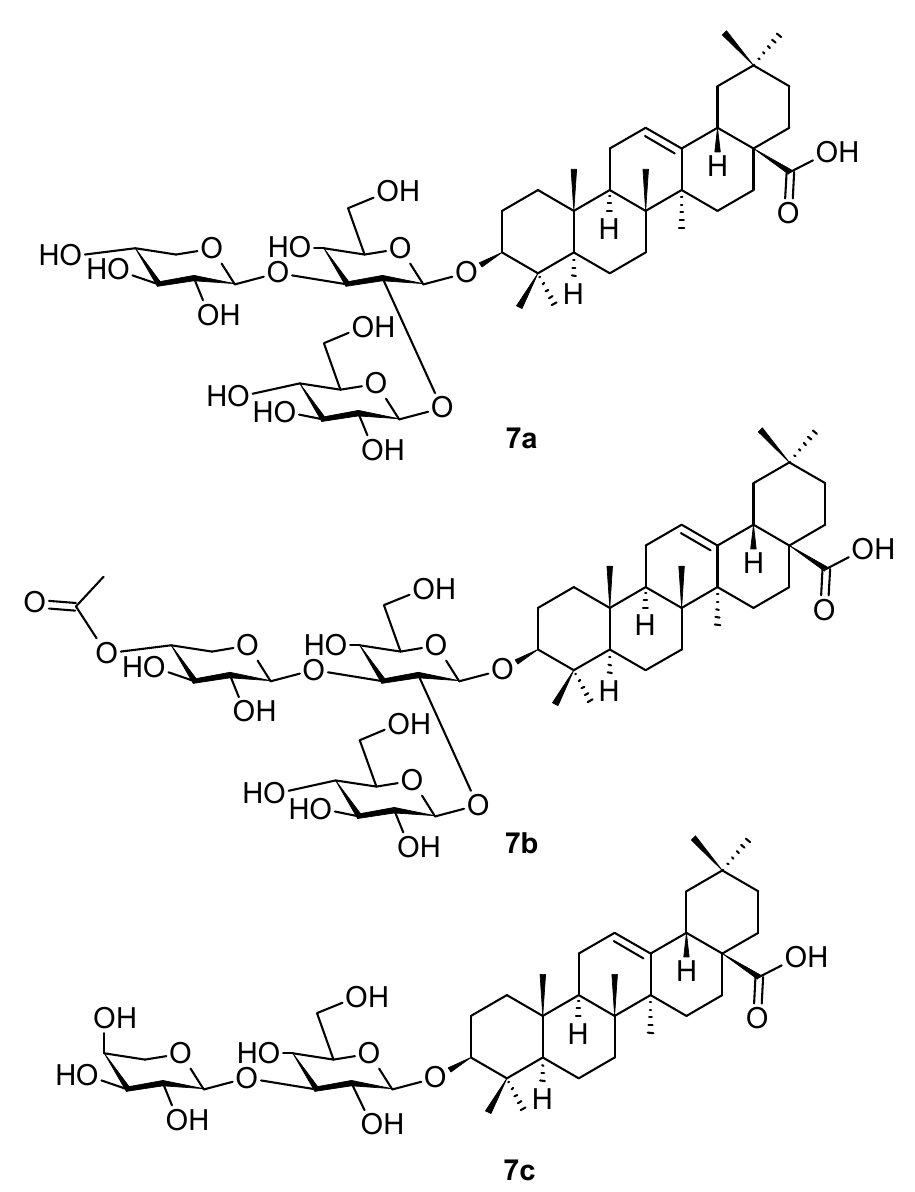
Figure 7. Oleanane-type lepiginosides 7a – 7c from the stem bark of Lepisanthes rubiginosa . Xanthoceraside ( 8 ; Figure 8), another oleanane-type saponin, was isolated from Xan- of the saponins of the oleanane-type of triterpenoids, have been isolated and identified from Platycodon grandiflorus Jacq. (Campanulaceae; Chinese bellflower), a well-known edible and medicinal plant [52]. The general formula 9a represents the platycodigenin-type of compounds, 9b represents the platygalacic-acid-type of compounds, and, finally, 9c represents the platyconic acid-type of compounds. Platycosides comprise 56 described plant products altogether [52]. They are the main active constituents of P.